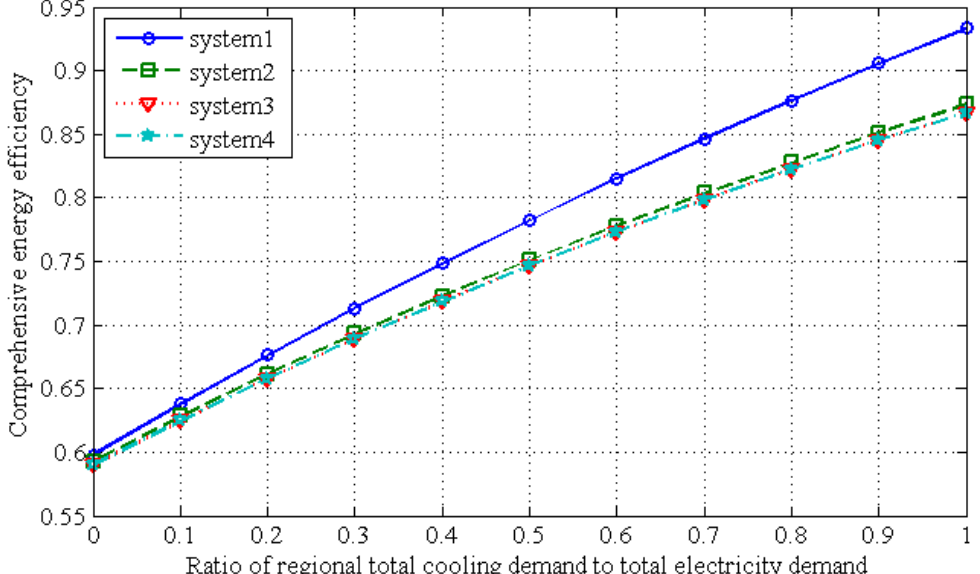
Appl. Sci. 2018 , 8 , 2372 Figure 8. The variation of optimal comprehensive energy efficiency with y. Figure 8. The variation of optimal comprehensive energy efficiency with y .